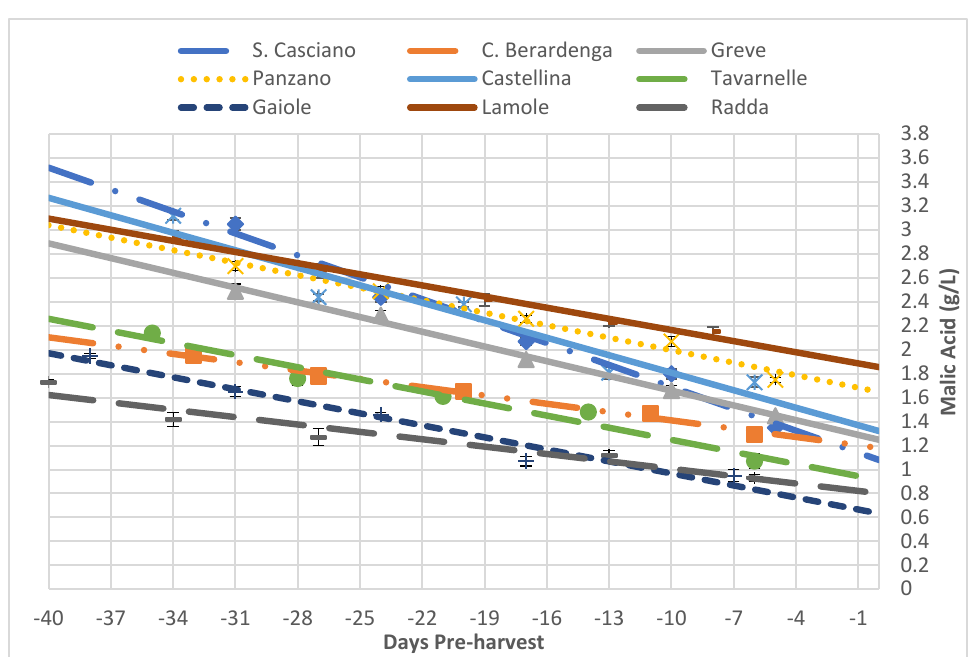
Figure 4. Trends of the malic acid in all the analysed vineyards as a function of time (expressed as negative days before the harvest). Each analytical point is reported with its 68% C.L. interval. Table 8. Calculated values of the functional parameters, intercept, slope and R 2 of the pH inside the grapes coming from the different